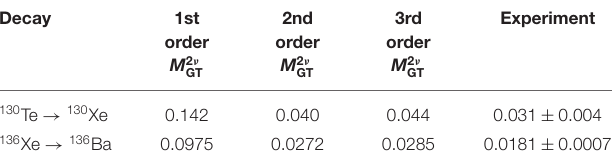
TABLE 3 | Order-by-order M 2 ν GT ’s (in MeV − 1 ) for 130 Te and 136 Xe [122]. Decay